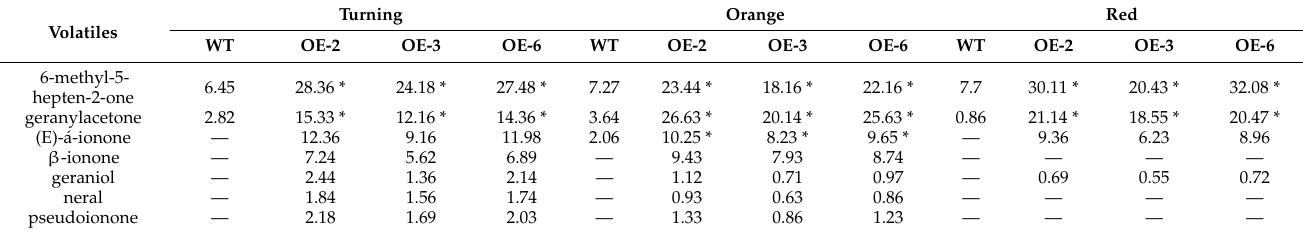
Table 3. OE of SlCCD1A on the contents of the carotenoid-derived volatiles in TI4001 tomato fruits ( µ g/kg). Turning Volatiles